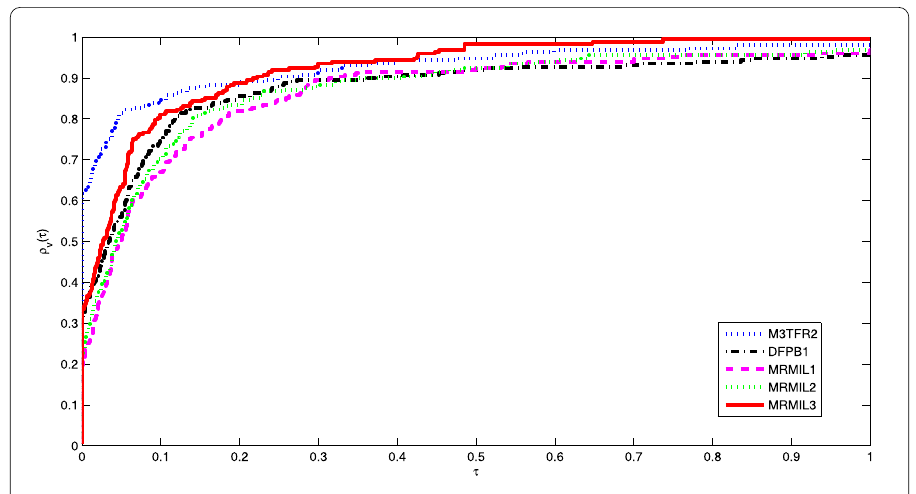
Figure 1 Performance profiles for the number of iterations in a log 2